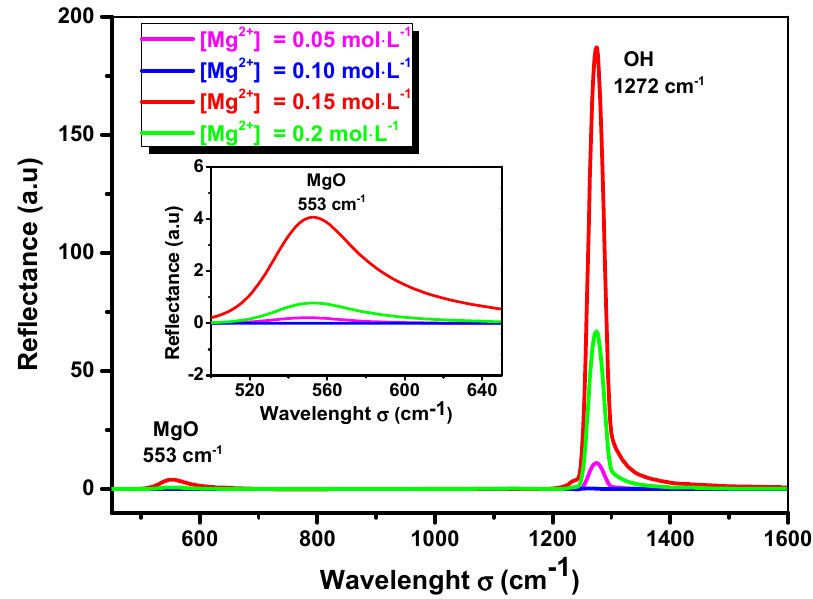
Figure 3. FTIR spectra of sprayed MgO thin films deposited with [Mg 2+ ] = 0.05; 0.10; 0.15 and 0.20 mol·L − 1 .